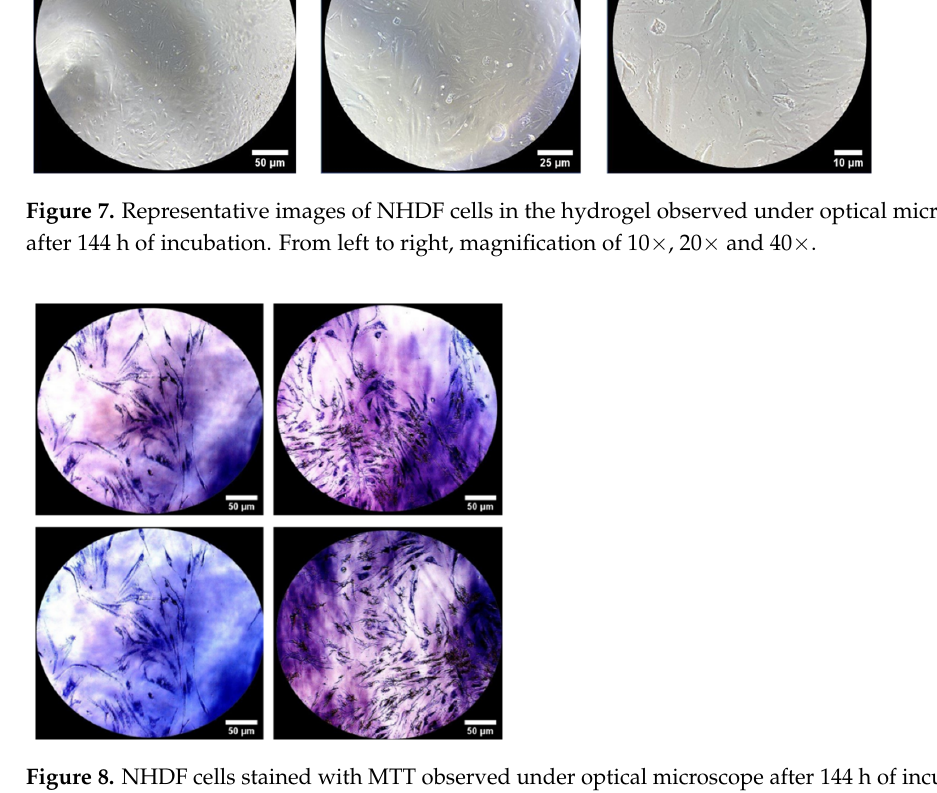
Figure 8. NHDF cells stained with MTT observed under optical microscope after 144 h of incubation (magnification 10×).